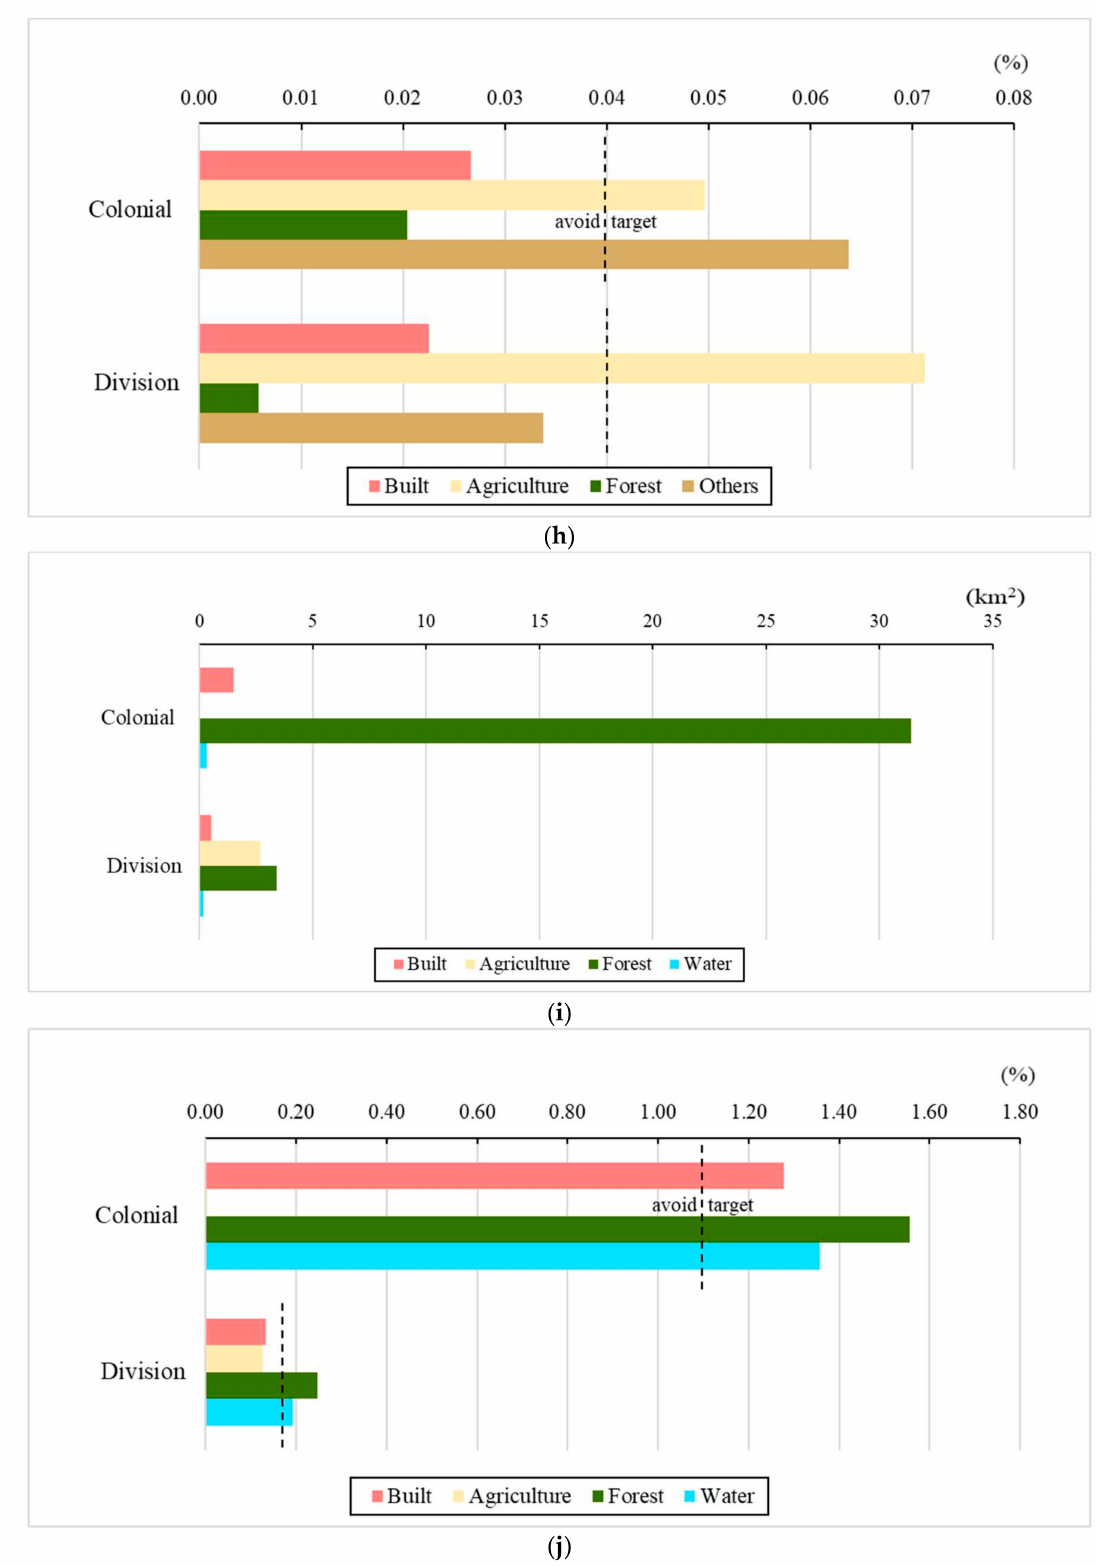
Figure 11. Transition level changes: ( a ) To Built (area), ( b ) To Built (intensity), ( c ) To Agriculture (area), ( d ) To Agriculture (intensity), ( e ) To Forest (area). ( f ) To Forest (intensity), ( g ) To Water (area), ( h ) To Water (intensity), ( i ) To Others (area), and ( j ) To Others